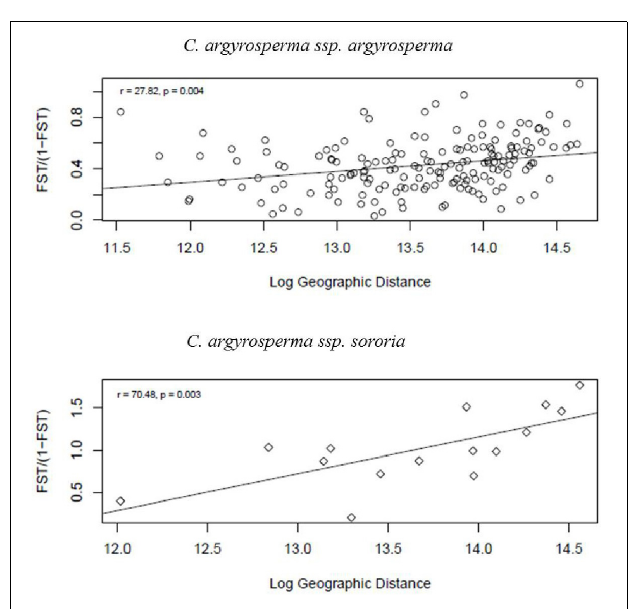
FIGURE 8 | Test of isolation by distance (IBD) obtained through a Mantel test. Results were significant, showing a strong positive correlation between geographic and genetic distances for both argyrosperma ( r = 27.8, p = 0.004), and sororia ( r = 70.04, p =